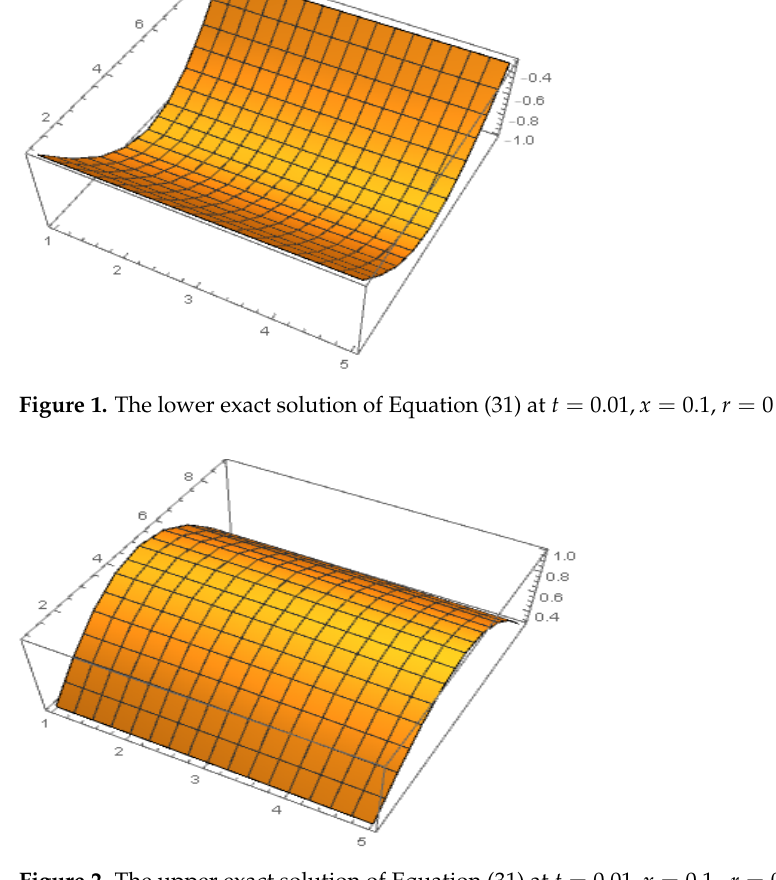
Figure 2. The upper exact solution of Equation (31) at t = 0.01, x = 0.1, r = 0 and β = 1.